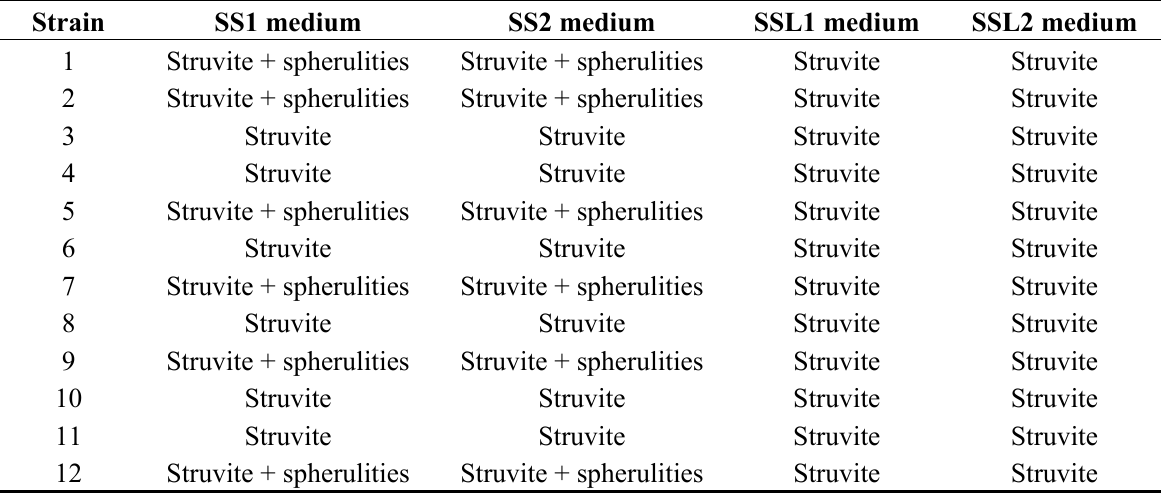
Table 3. Formation of phosphate crystals by bacterial strains isolated from submerged fixed-film bioreactor in solid and liquid media.